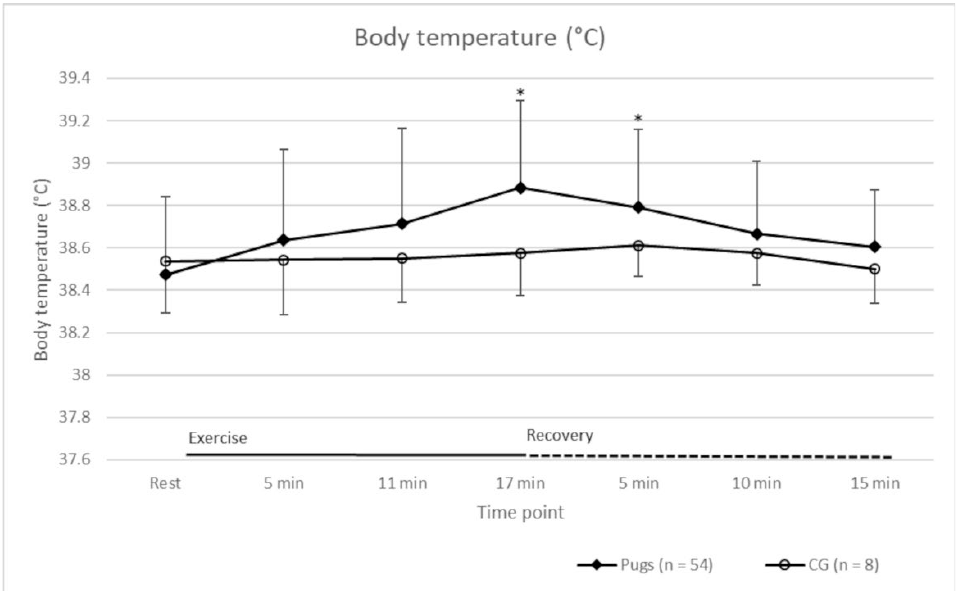
Figure 1. Mean heart rate (beats per minute, bpm) (± standard deviation) of pugs ( n = 54) and control group (CG) ( n = 8) at rest, during exercise, and throughout recovery period. Statistically significant differences between the groups at the measurement time points are indicated by an asterisk (*).